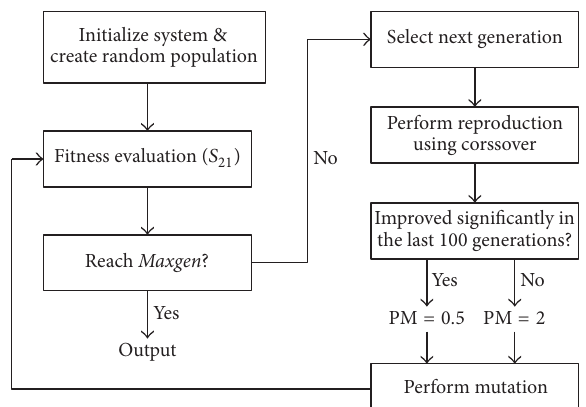
Figure 10: Program